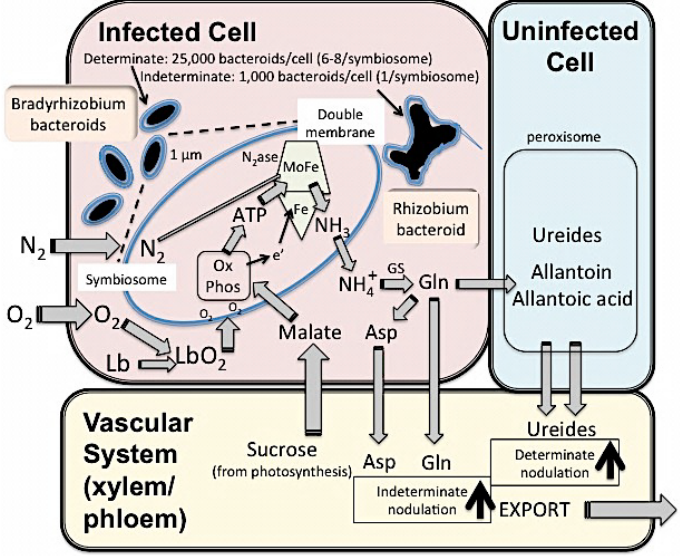
Figure 3. Schematic mechanisms of symbiotic nitrogen fixation in a legume nodule. N entering the symbiosome is converted to NH 4+ by the nitrogenase enzyme complex of 2 the bacteria using ATP and an electron donor. The NH 4+ is then converted to glutamine via glutamine synthase (GS) and asparagine. Glutamine is exported from the infected cell to uninfected cells where in the peroxisomes ureides, such as allantoin and allantoic acid are synthesised. All the nitrogen transport molecules (Gln, Asp, ureides) are exported to and transported via the vascular system to the rest of the plant. Note that indeterminate and determinate differ in their spectrum of transport molecules. Ureides are highly beneficial as their have a 1:1 carbon:nitrogen ratio (compared to 2:1 for glutamine and